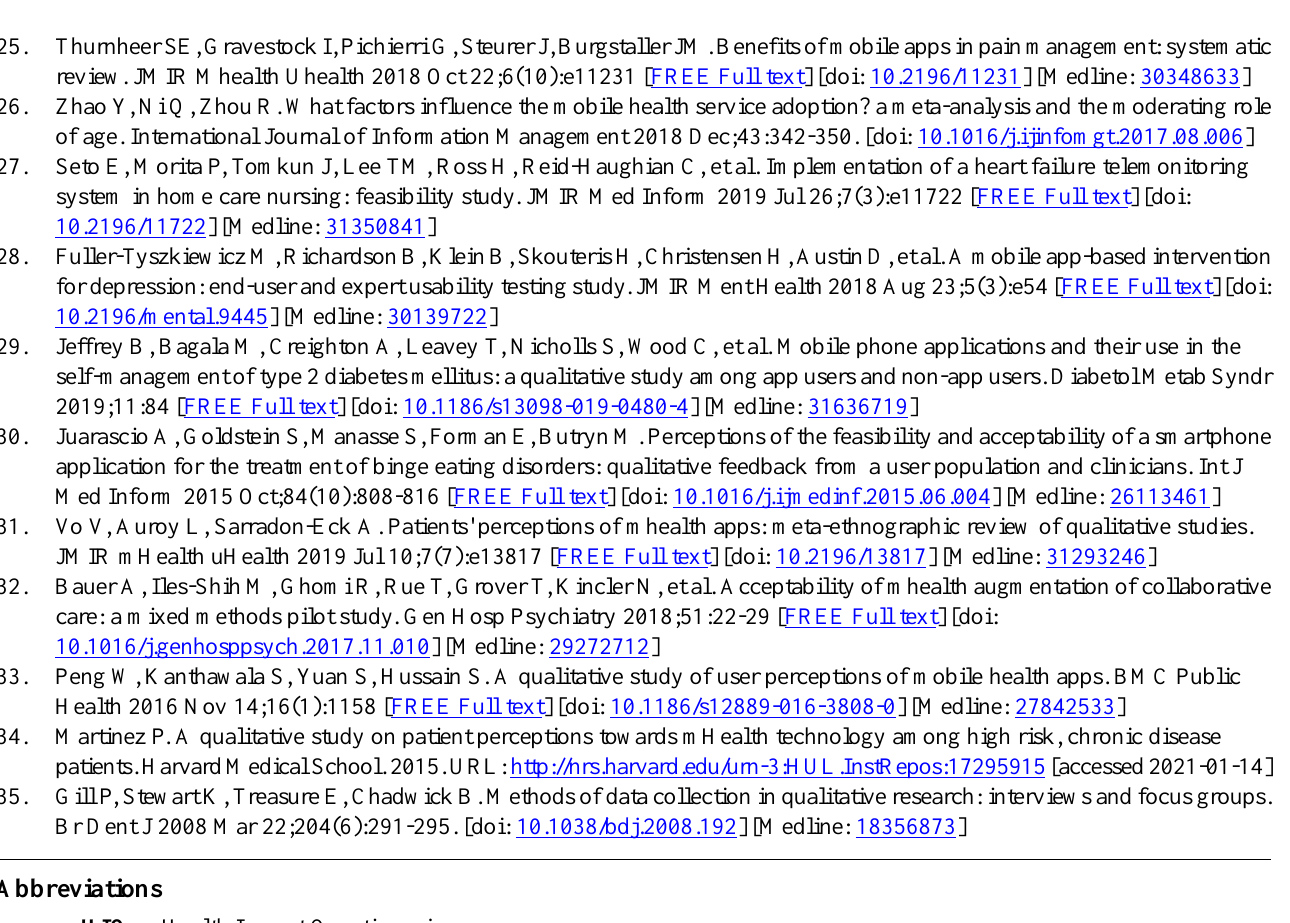
eHIQ: eHealth Impact Questionnaire mHealth: mobile health SUS: System Usability